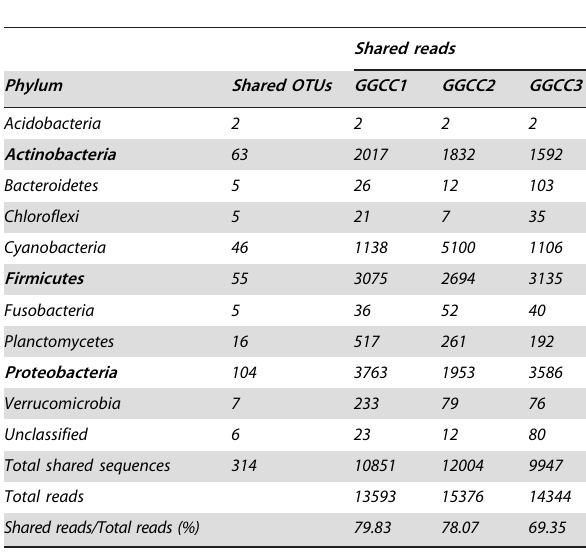
Table 2. Shared phyla among the GGCC